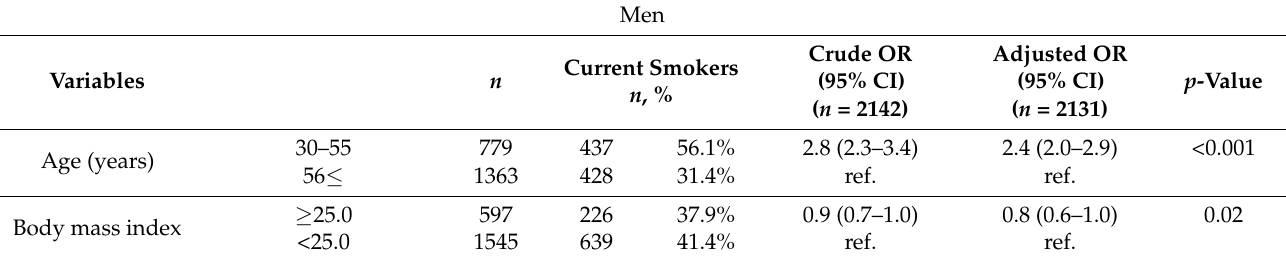
Table 3. Gender differences in smoking